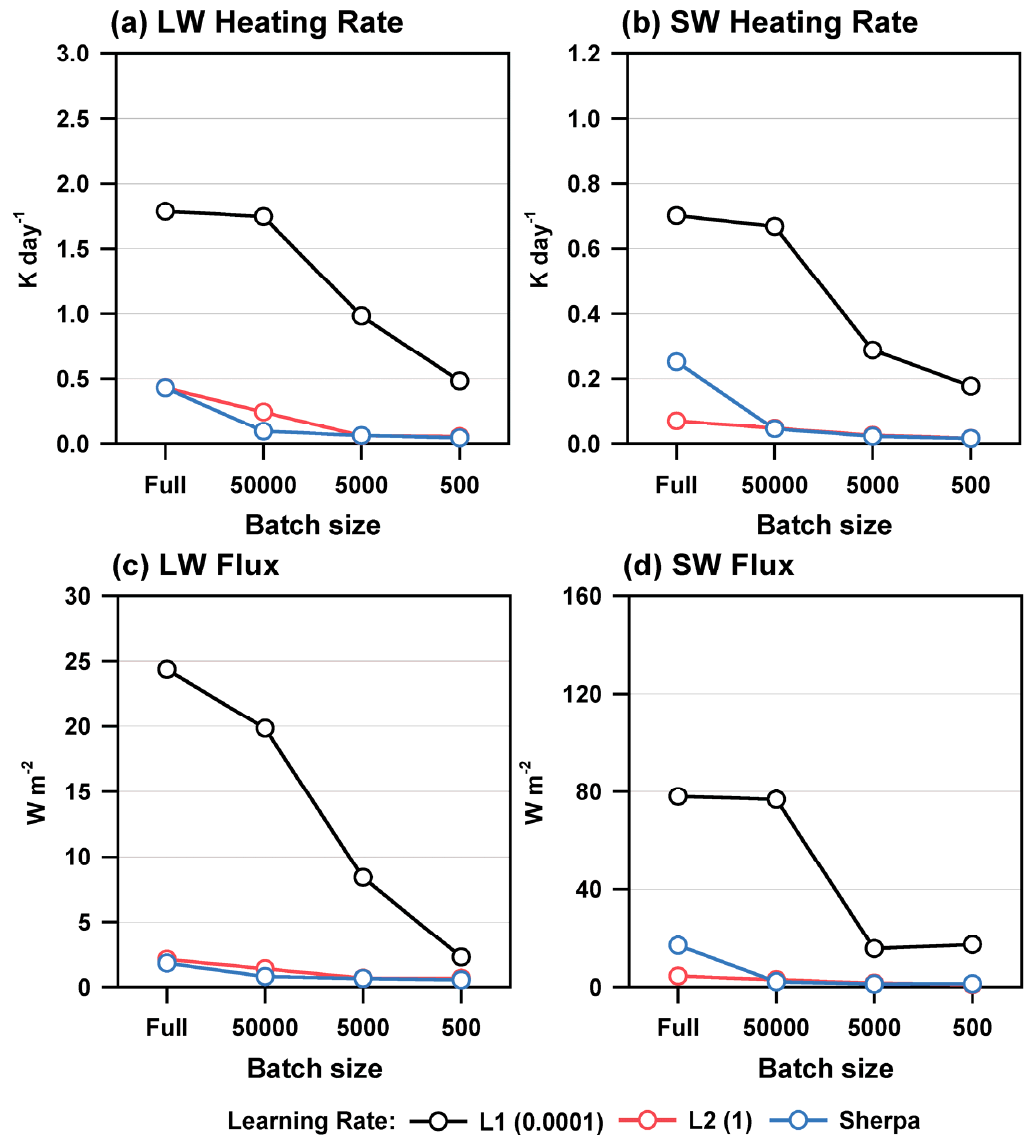
Figure 2. The root mean square errors (RMSEs) of ( a ) LW heating rate, ( b ) SW heating rate, ( c ) LW flux, and ( d ) SW flux with different batch sizes and learning rates for clear